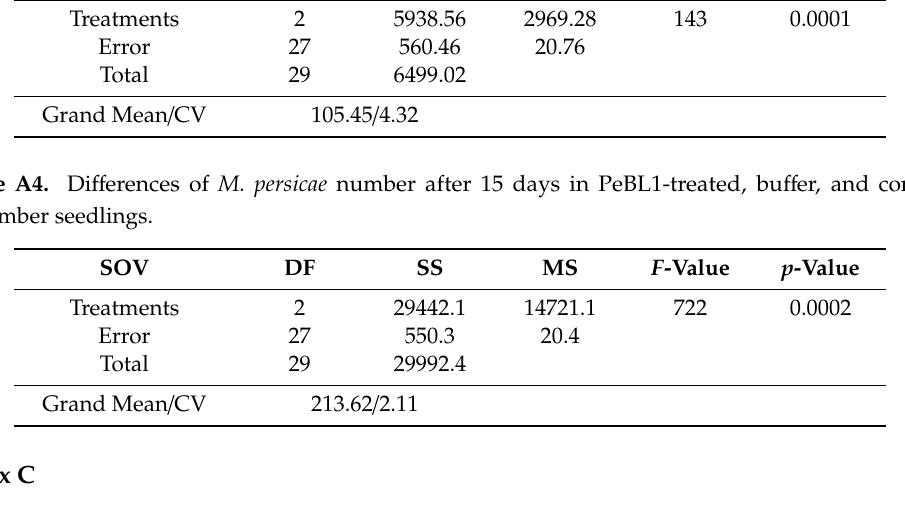
Table A5. Number of M. persicae colonized on control cucumber seedlings, PeBL1-treated cucumber seedlings, and